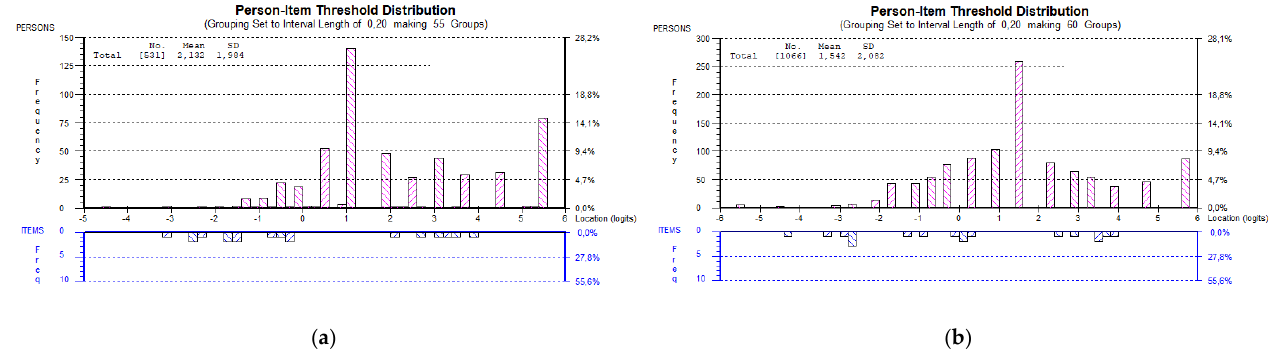
Figure 3. ( a ) Person item distribution for HLS 19 ‐ COM ‐ P ‐ Q6 in the Czech Republic based on CATI data. ( b ) Person item distribution for HLS 19 ‐ COM ‐ P ‐ Q6 in the Czech Republic based on CAWI data.